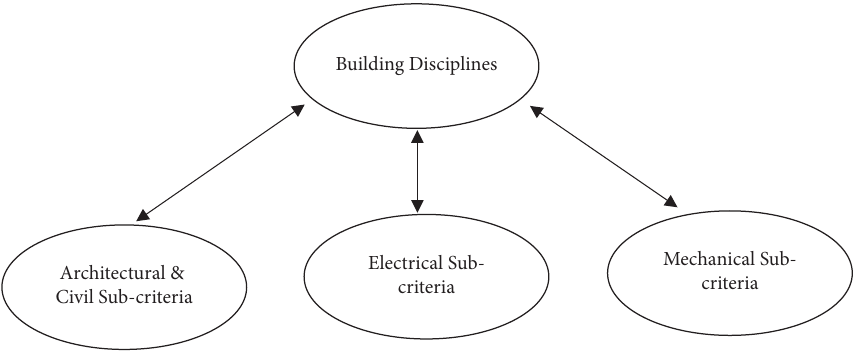
Figure 2: Te network of infuences between building categories and their